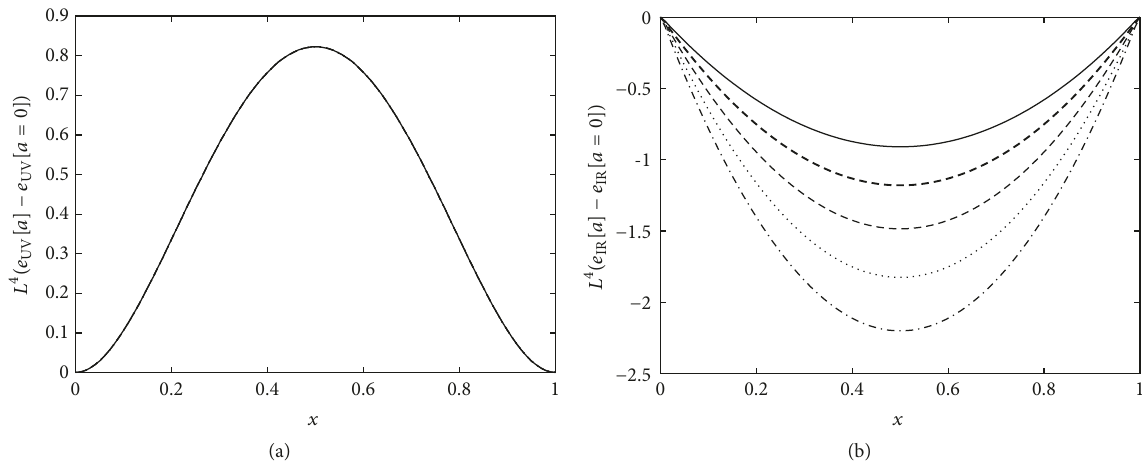
Figure 15: The effective potential of the Polyakov loop 𝑒(𝑎, 𝐿) (71) as function of the background field 𝑥 = 𝑎 3 𝐿/2𝜋 . The curvature is neglected (𝜒 = 0) and the gluon energy assumed to be (a) 𝜔(𝑝) = 𝑝 (UV form) and (b) 𝜔(𝑝) = 𝑀 2 /𝑝 (IR form), respectively; see [31] for more details.